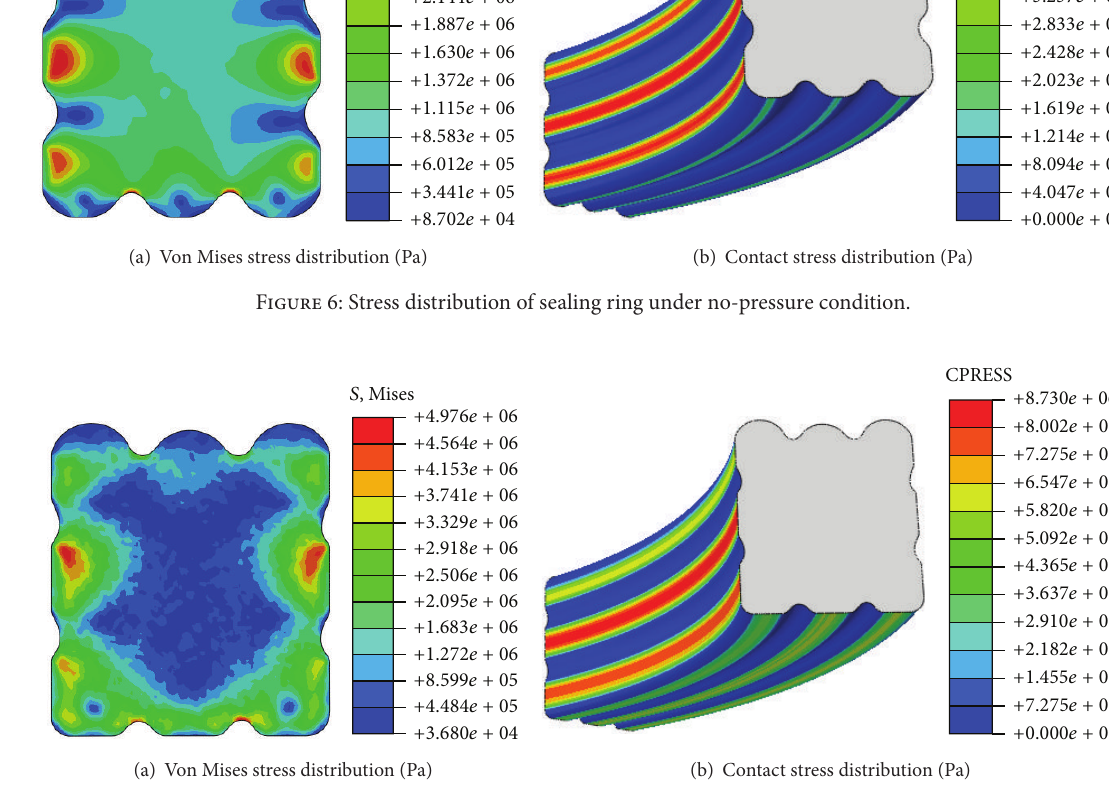
Figure 7: Stress distribution of sealing ring when 𝑃 = 3